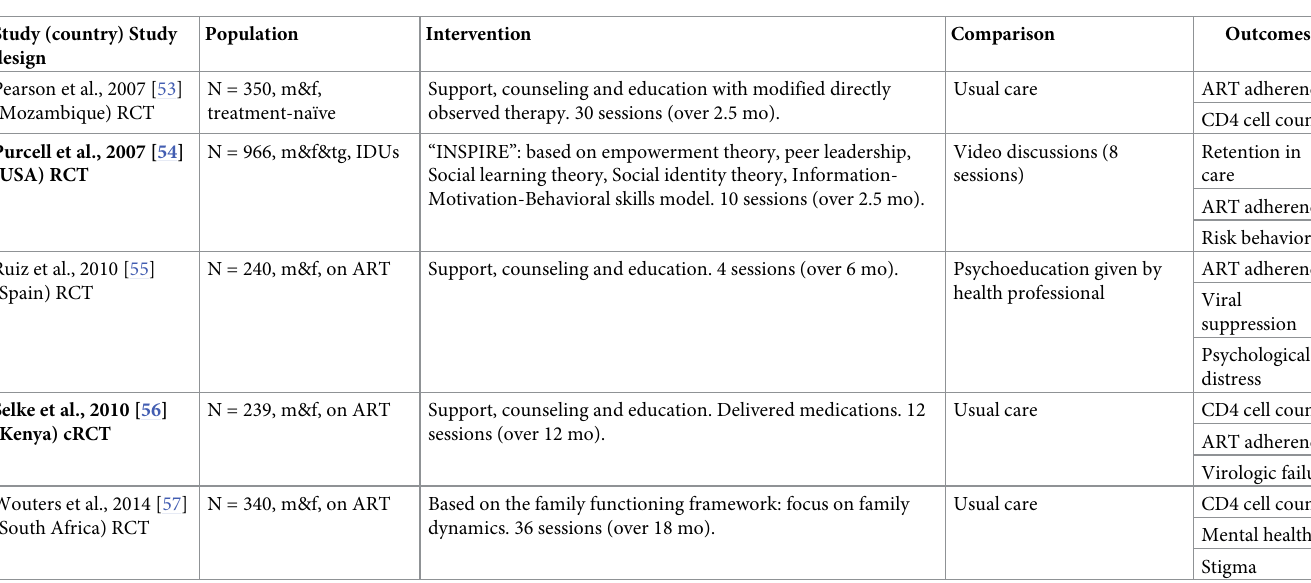
Legend: ART = antiretroviral therapy, cRCT = cluster randomised controlled trial, f = female, IDU = injection drug user, m = male, mo = month, MSM = men who have sex with men, N O = number, tg =